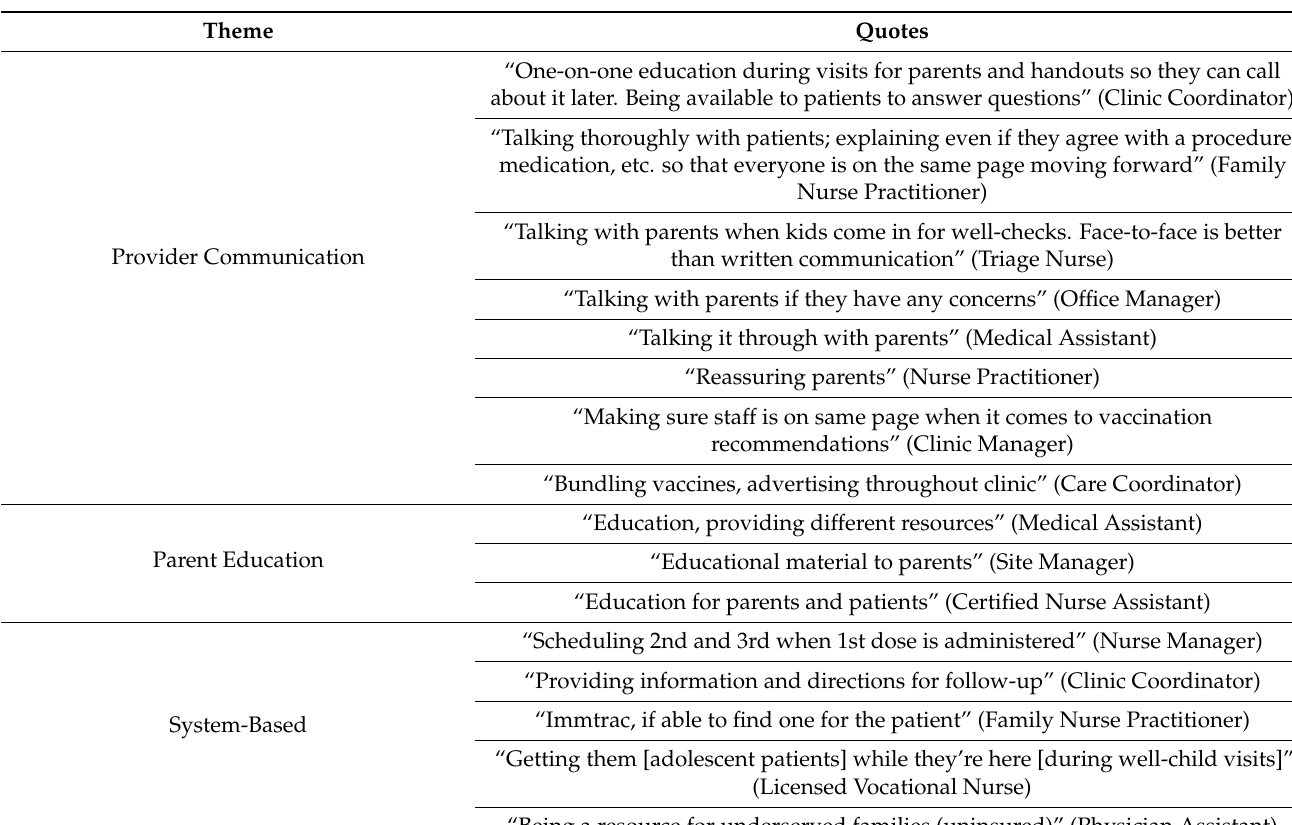
Table 3. Reported strategies perceived to be most helpful for HPV